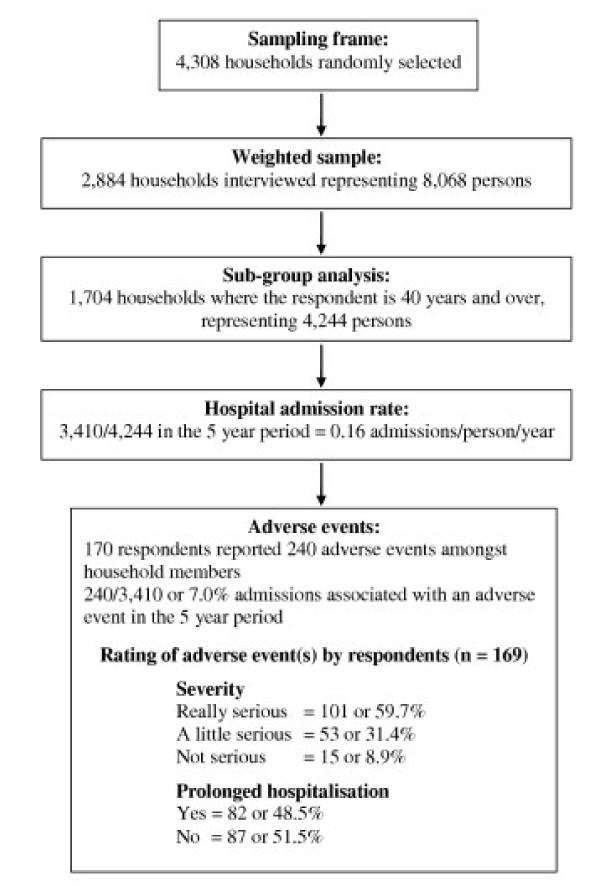
Flow diagram of adverse event rate and severity.